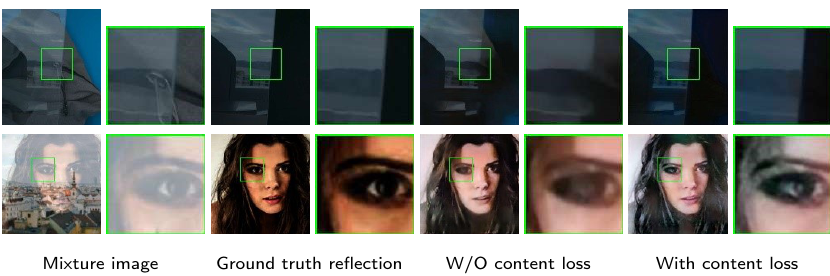
Figure 13. Comparisons of visual effects of the proposed network with or without content loss for Ours(b). The green boxes are partially enlarged for a better view. Table 4. Quantitative ablation study of Ours(a) network for the SR module and content loss.